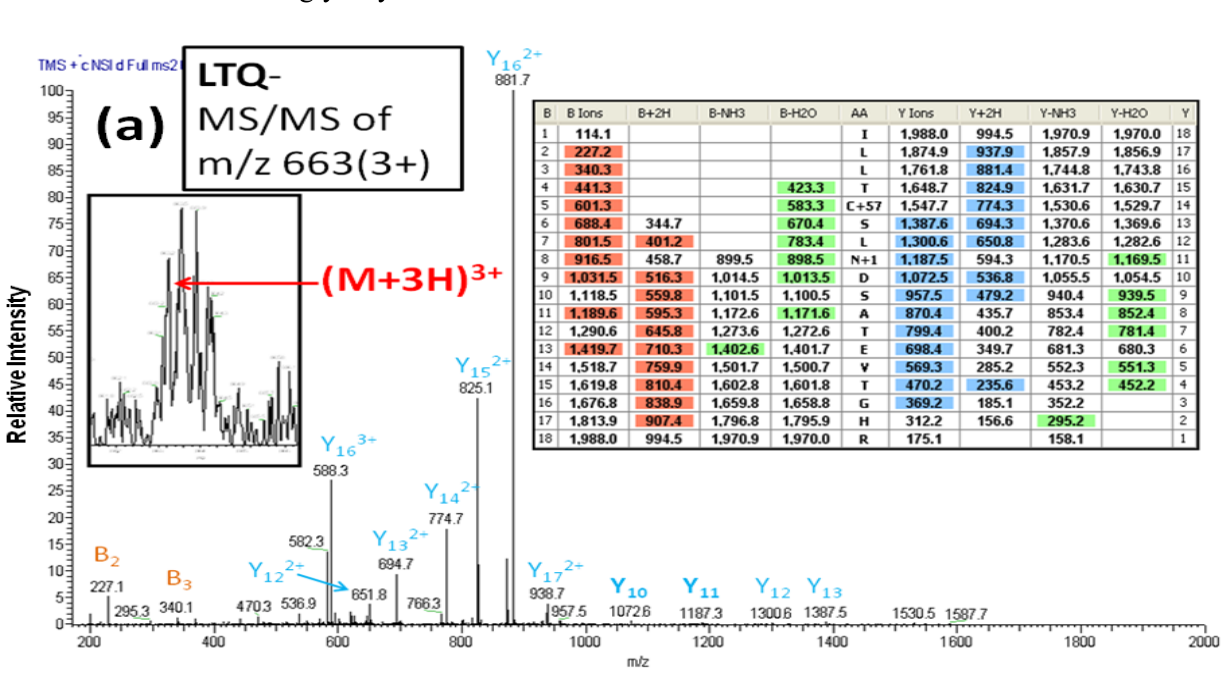
Figure 5. The CID-MS/MS spectrum ( a ) and HCD-MS/MS spectrum ( b ) of a triply charged precursor ion of the glycopeptide ILLTCSLN*DSATETGHR (AA#153-170,